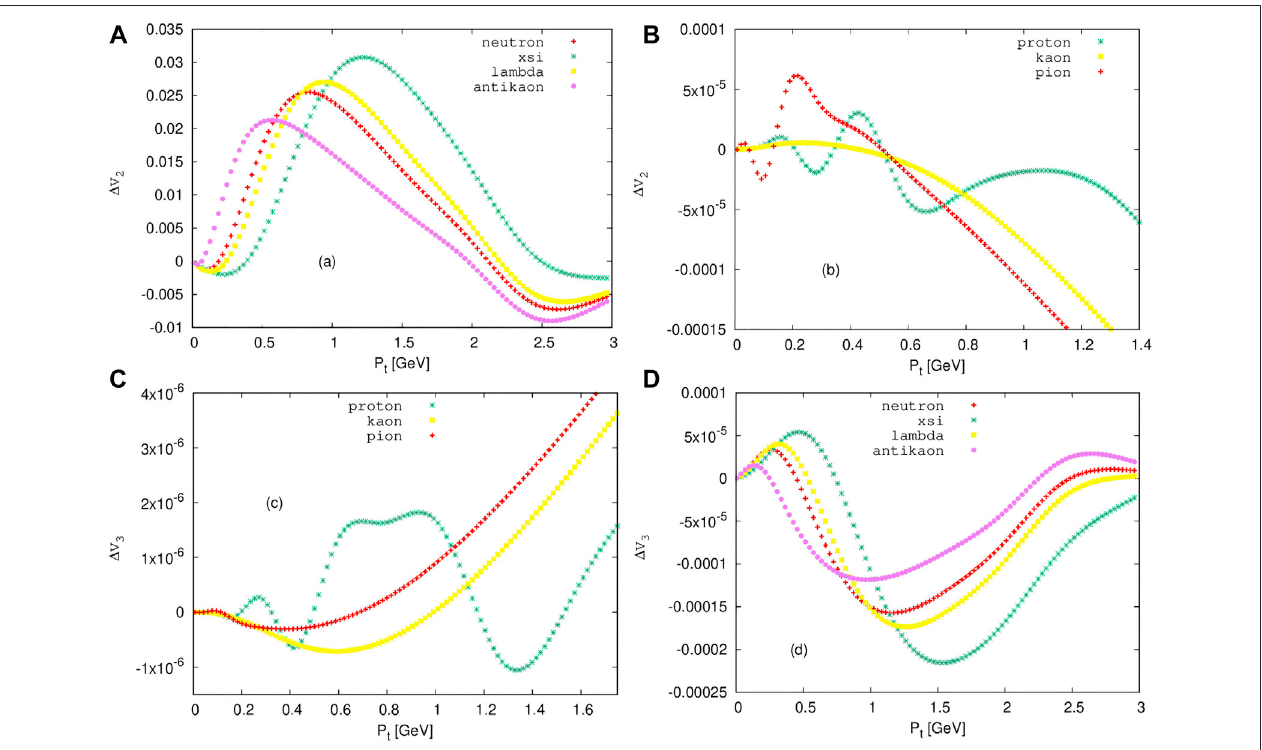
FIGURE4| (Coloronline) (A) :Illustratestheeffectofelectromagneticforceonthechangeinelliptic fl ow Δ V2forneutron,xsi,antiproton,lambdaandantikaon. (B) : Illustratetheeffectofelectromagneticforceonthechangeinelliptic fl ow Δ V2forproton,kaonandpion. (C) :Illustratetheeffectofelectromagneticforceonthechangein triangular fl ow Δ V3 for proton, kaon and pion, and (D) : Illustrate the effect of electromagnetic force on the change in triangular fl ow Δ V3 for neutron, xsi, antiproton, lambda and anti kaon.